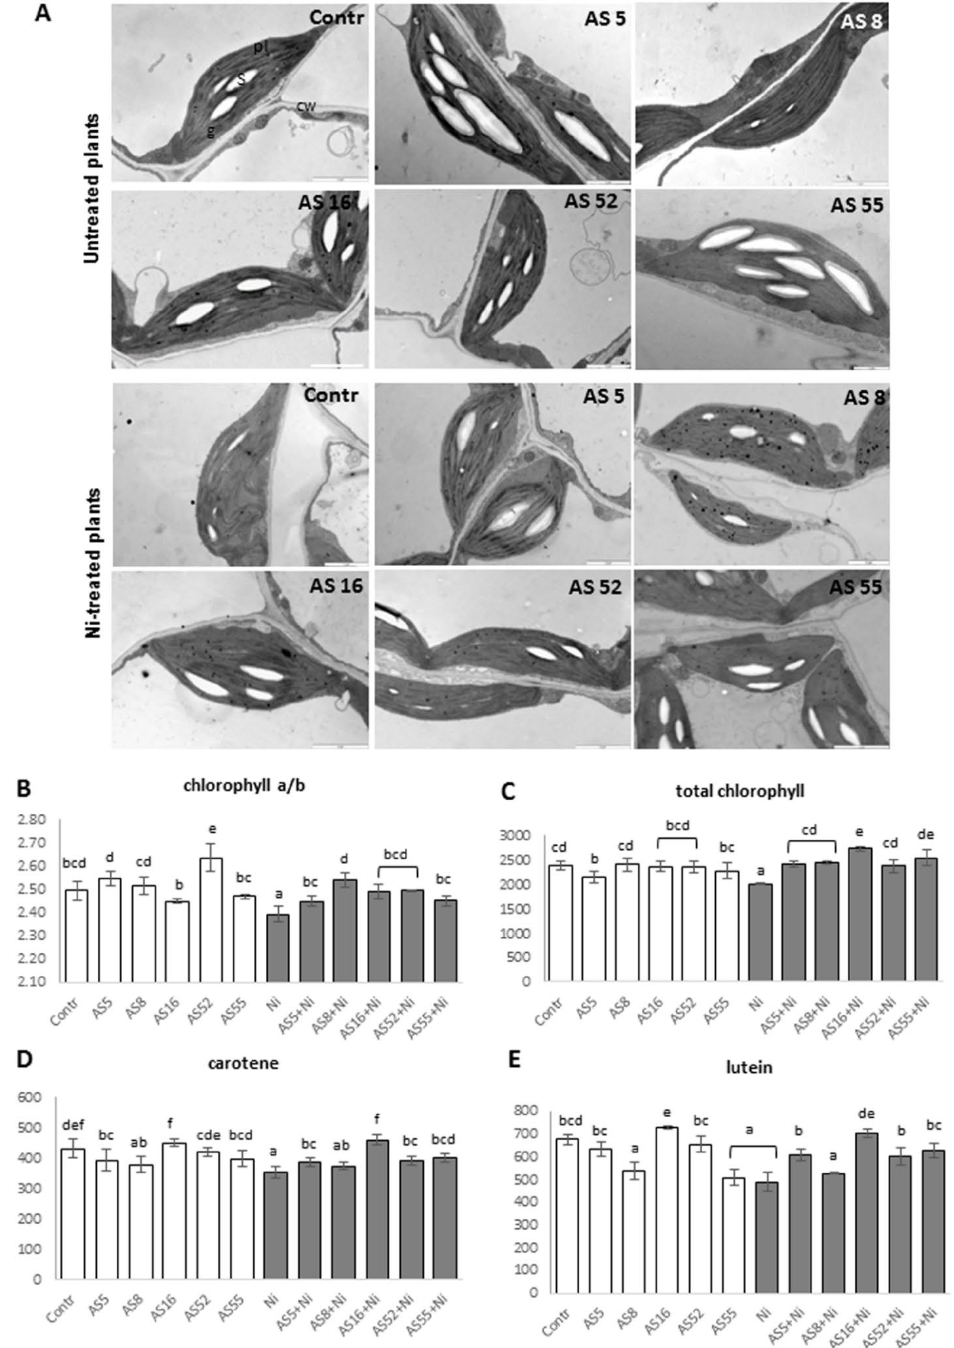
Figure 7. ( A ) Transmission electron micrographs showing leaf chloroplast ultrastructure of Arabidop- sis untreated and Ni-treated, grown in the absence (Contr) or presence of rhizobia (AS5, AS8, AS16, AS52, or AS55, respectively). Note that there was higher starch accumulation in the chloroplasts of Arabidopsis leaves inoculated with isolates AS5, AS16, AS52, and AS55 under control and Ni-stress conditions. Abbreviations: cw, cell wall; s, starch grain; g, granum; pl, plastoglobuli. Scale = 2 µ m. ( B ) Photosynthetic pigments: chl a/b, ( C ) total chlorophyll (a + b), ( D ) carotene, and ( E ) lutein contents of 4-week-old Arabidopsis plants non-exposed (bars in white) and exposed to 200 µ M Ni (bars in grey), in the absence or presence of rhizobia. Different letters indicate a statistically significant difference among treatments in ANOVA comparisons and the post-hoc Tukey HSD at the level p = 0.05. Error bars represent ±